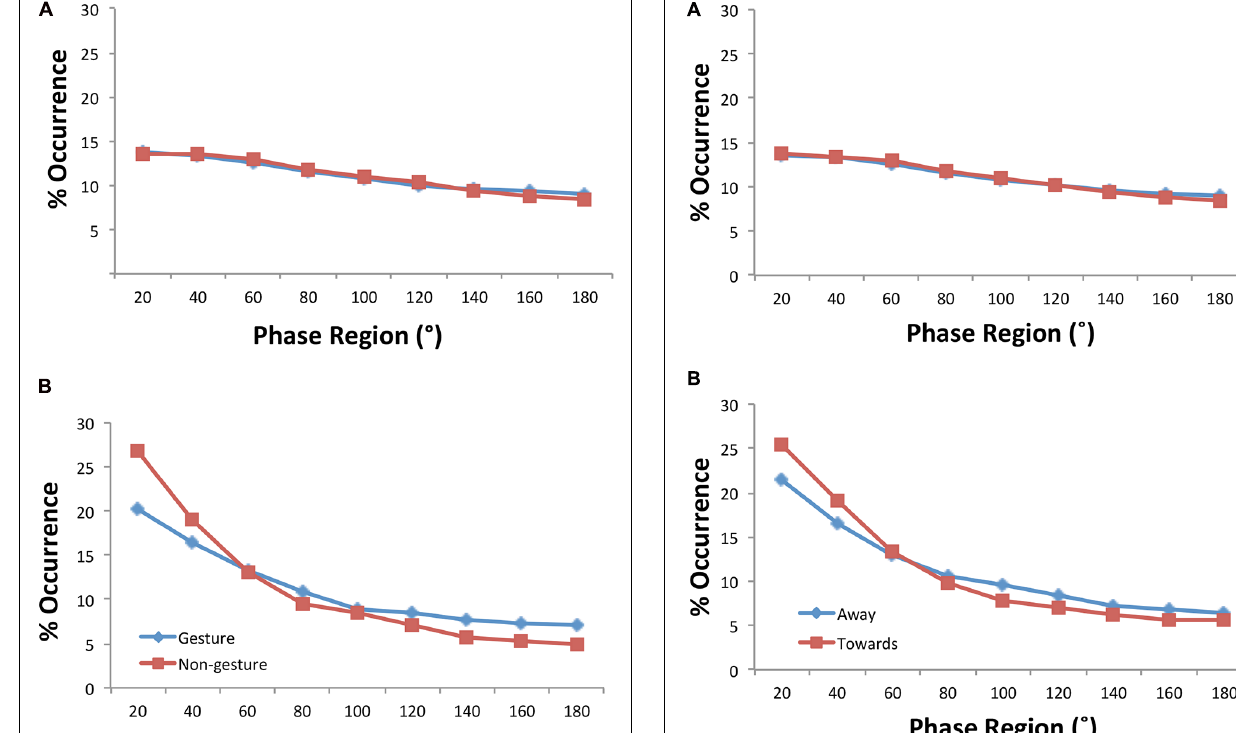
exhibited inphase activity and exhibited greater inphase activity when the participants were facing toward each other (at 0 and 20 ◦ : p s < 0.05).